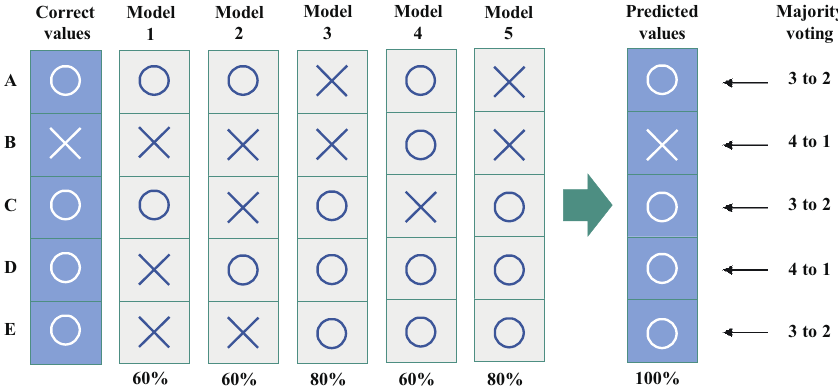
Figure 3. Example of majority voting with ensemble learning.